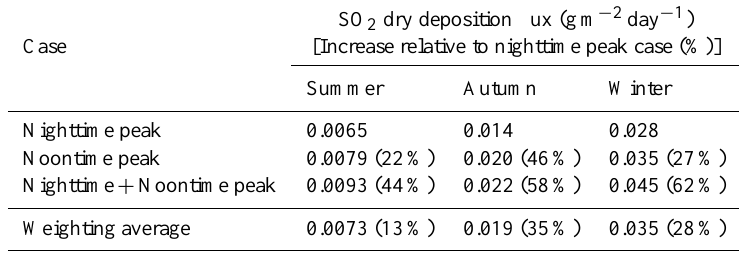
Table 3. Estimated SO 2 dry deposition flux for the three different SO 2 diurnal variation patterns, the occurrence frequency (of the three groups) weighting averaged value, and the relative increase compared to the nighttime peak case.